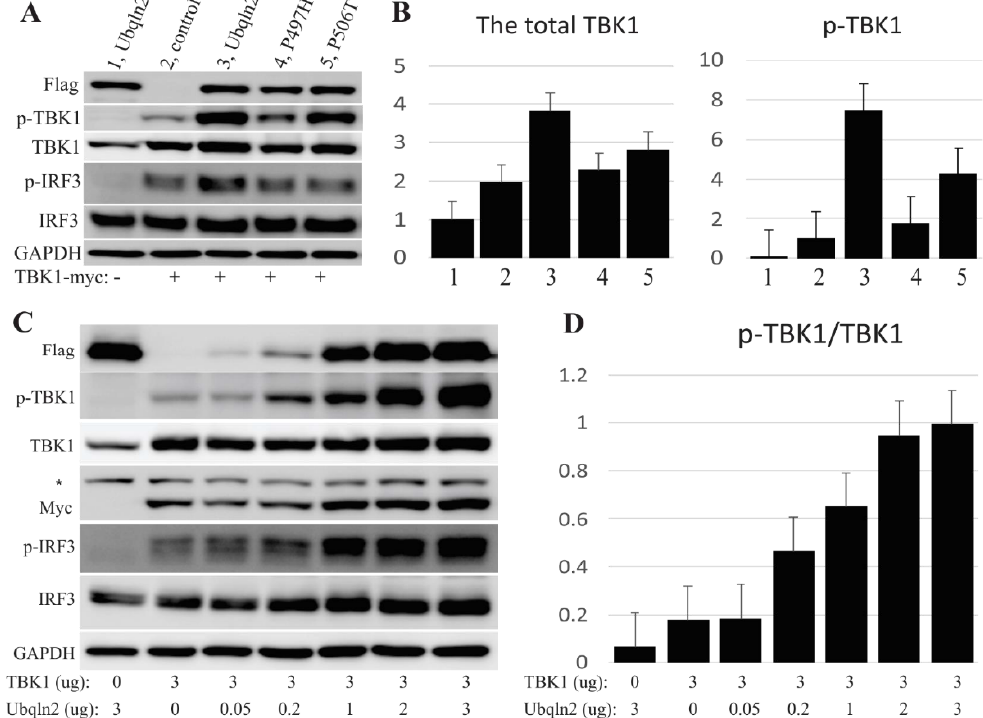
Figure 3. UBQLN2 promotes TBK1 phosphorylation. ( A ) Immunoblot analysis revealed the expression levels of TBK1 and IRF3 when co-expressed with UBQLN2. The empty vector was co-transfected as the control. Each lane was loaded with 10 µ g total protein, and GAPDH was used as the loading control. Human UBQLN2 and TBK1 were tagged with Flag or Myc and co-transfected into HEK-293T cells. ( B ) Graphs showing the relative levels of TBK1 based on GAPDH and the relative levels of p-TBK1 based on TBK1, calculated from the panel ( A ). ( C ) HEK-293T cells that were seeded into 10-cm dishes were co-transfected with TBK1 and varying amounts of UBQLN2 (0, 0.05, 0.2, 1, 2, 3 µ g). Cells were harvested 48 h after transfection. Immunoblot reveals the levels of p-TBK1, TBK1, p-IRF3 and IRF3, in response to increasing expression of UBQLN2. An asterisk indicates non-specific bands detected by anti-myc. ( D ) Ratios of p-TBK1 to total TBK1, calculated from Panel C. Note: the total TBK1: TBK1; the phosphorylated TBK1: p-TBK1; the total IRF3: IRF3; the phosphorylated IRF3: p-IRF3.